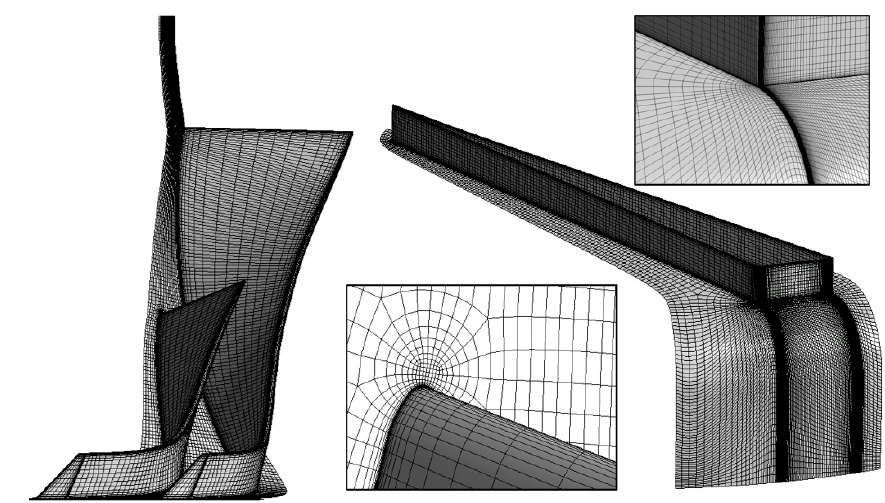
Figure 2. Grid systems of the numerical analysis.